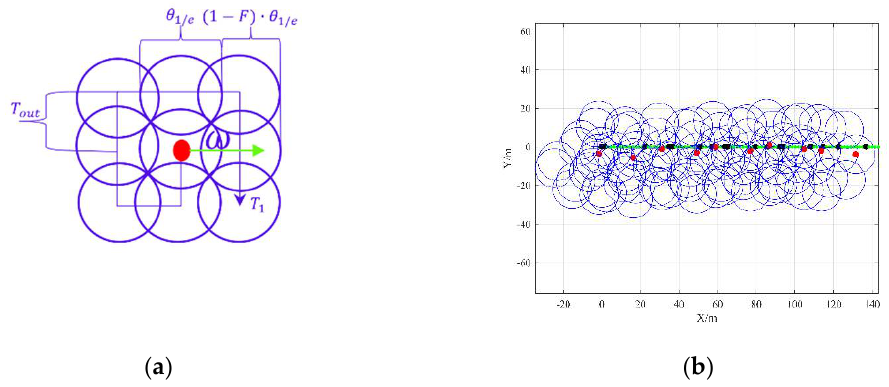
Figure 10. ( a ) The raster spiral scan pattern; ( b ) the APT of a dynamic target ( x 0 = 0, y 0 = 0, v = 788.89, (cid:2009) = 0, (cid:1878) (cid:4593) = 100,000 ).